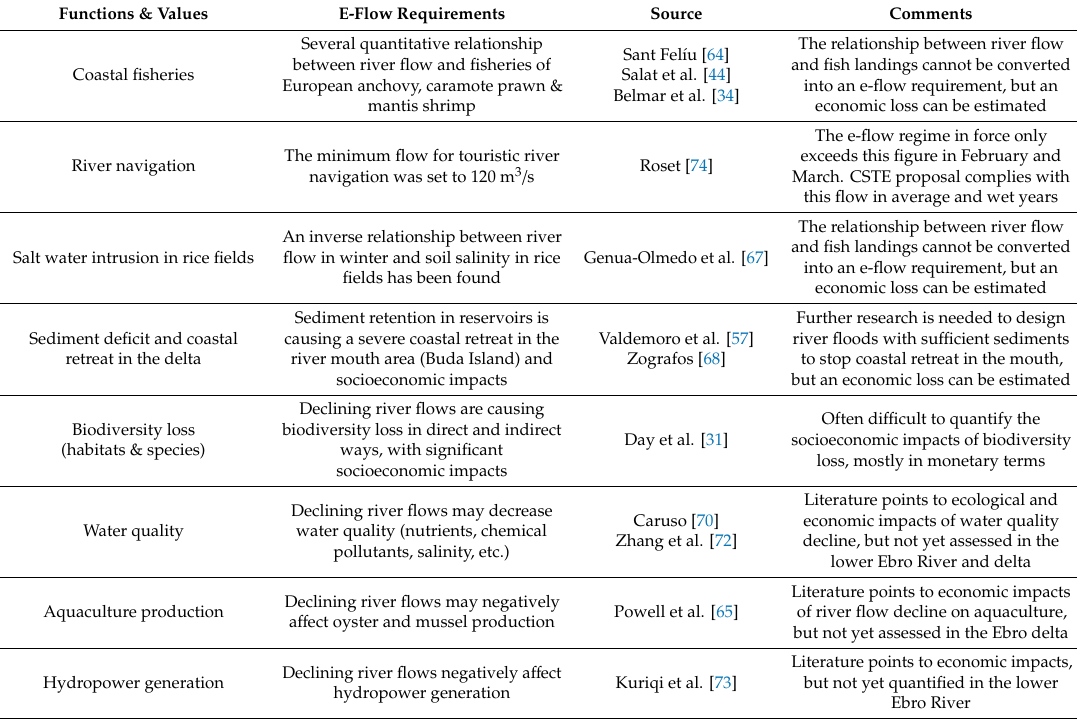
Table 4. Relationship between river flows and socio-economic functions and values of the lower Ebro River and delta that have been assessed with existing information, mostly qualitative because of the lack of